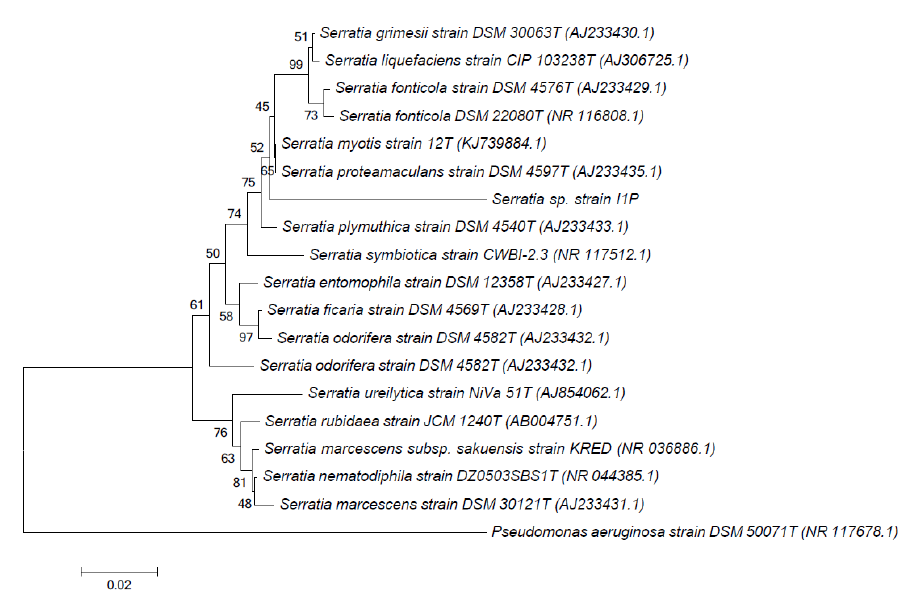
Figure 1. Neighbor-joining phylogenetic tree based on 16S rRNA gene sequences of species from the Serratia genus. The percentage of replicate trees in which the associated taxa clustered together in the bootstrap test (1000 replicates) are shown next to the branches. Pseudomonas aeruginosa DSM 50071T was used as an out-group. Bar, 2 nucleotide substitutions per 100 nucleotides.